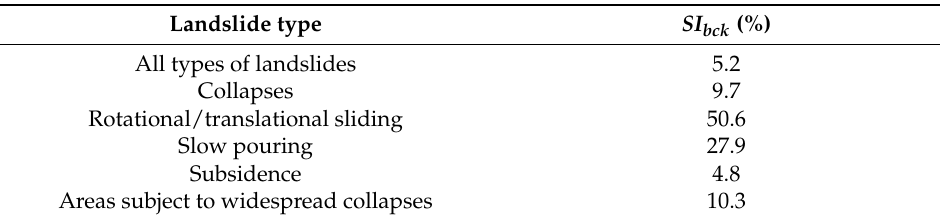
Figure 10. SM frequency distribution related to the background and to the various sliding types. Table 2. SI bck computed for the various landslide types